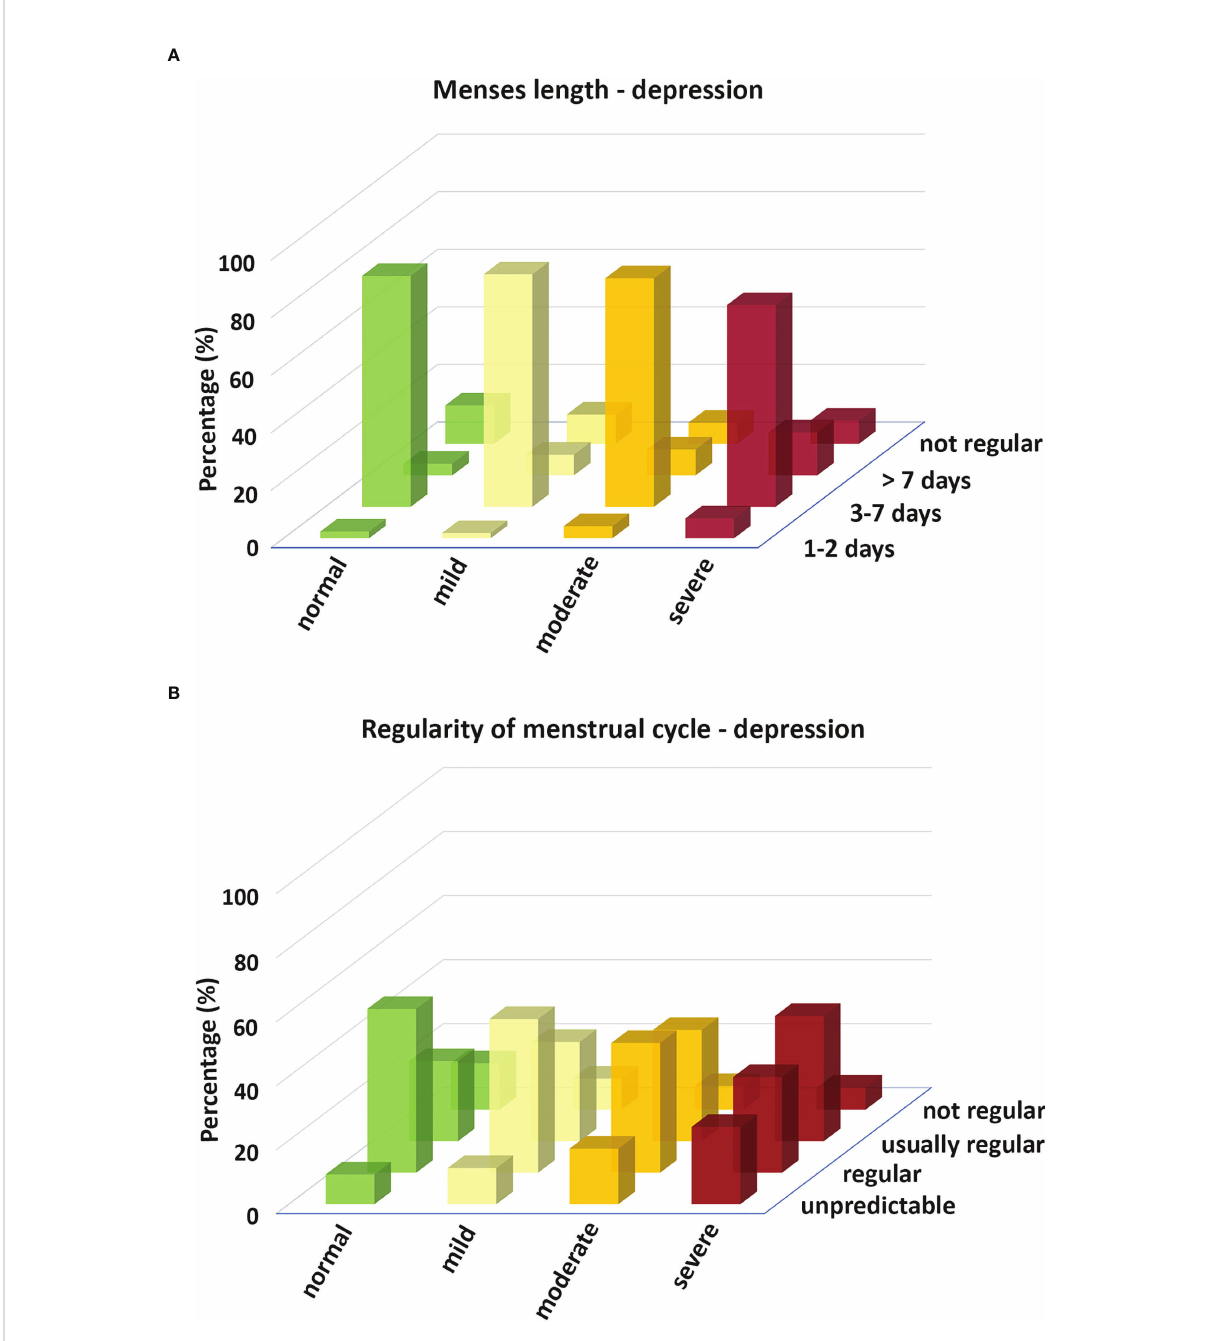
FIGURE 5 Histograms depict the menses length (A) and the regularity of the menstrual cycle (B) in relation to the severity of depression determined by the